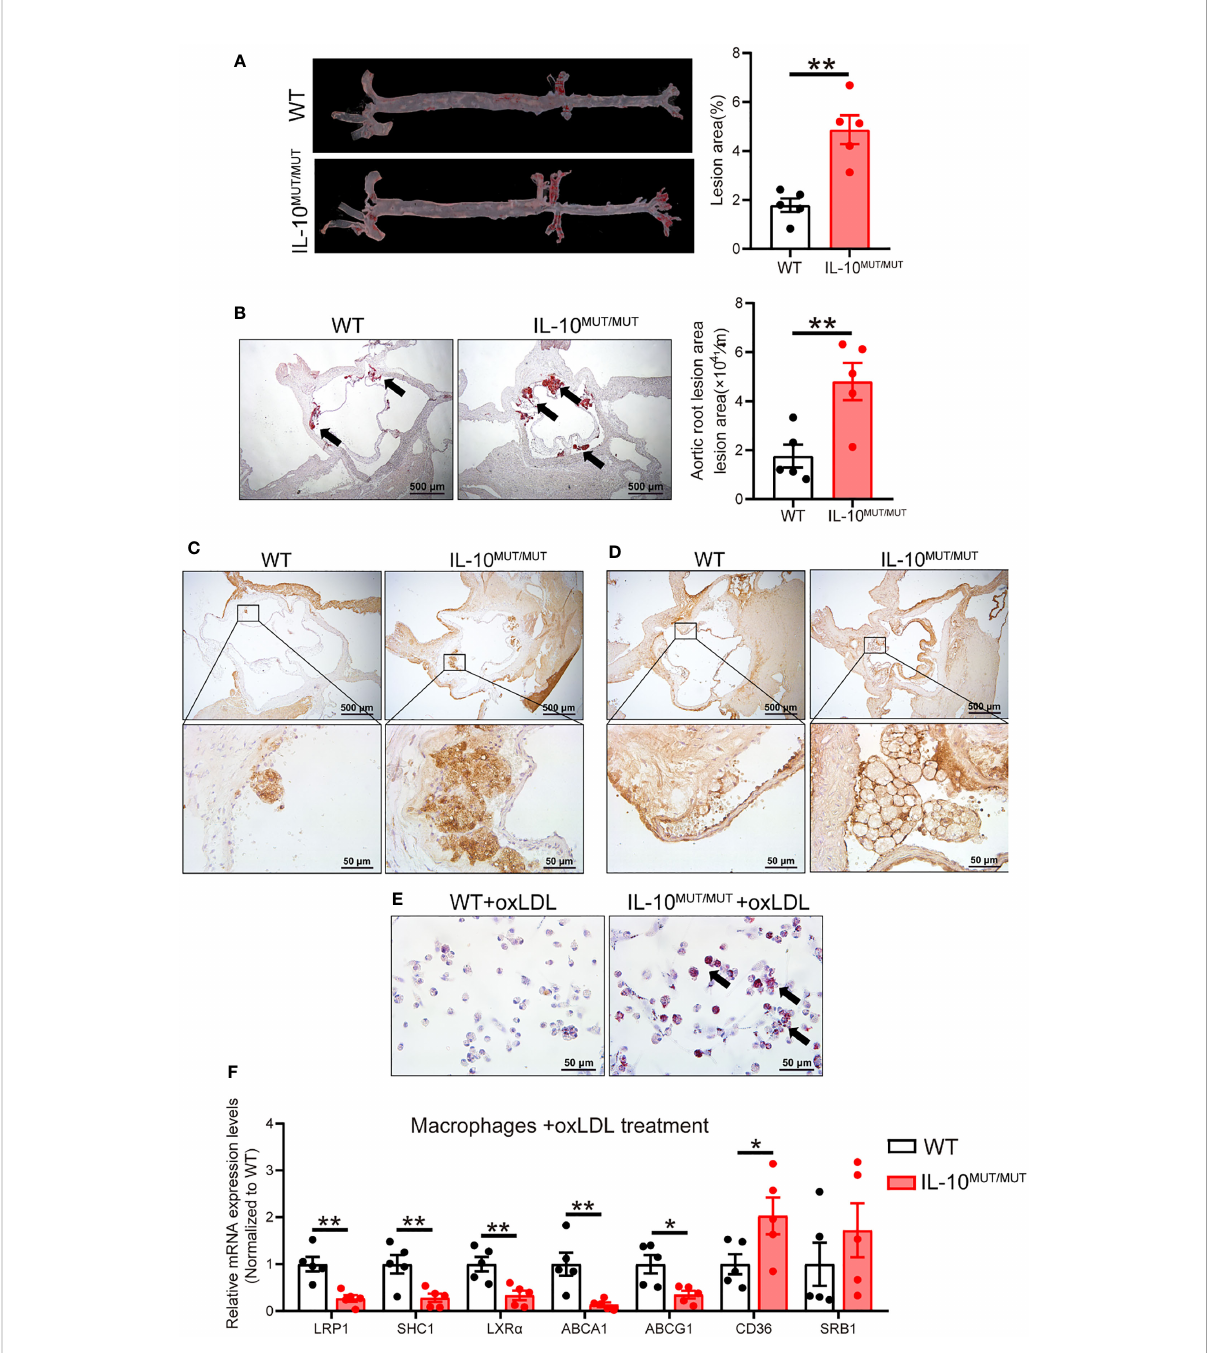
FIGURE 7 IL-10 de fi ciency accelerated atherosclerotic development in HFD-fed hamsters. (A, B) Analysis of atherosclerotic lesions in whole aorta (A) and sectioned aortic roots (B) . Representative images were shown in left panel and quanti fi cation was analyzed in right panel (n=5/group). Arrows indicate ORO-positive lesions. (C, D) Immunohistochemistry of CD68 (C) and LPS (D) in aortic roots from WT and IL-10 MUT/MUT hamsters on HFD. Bars: 500 m m (top) and 50 m m (bottom). (E) Representative photomicrographs of macrophages stained with ORO. Bars: 50 m m. Arrows indicate ORO positive cells. (F) Expression levels of genes involved in lipid uptake and RCT were determined by real-time PCR (n=5/group). All date were expressed as means ± SEM, *p<0.05;